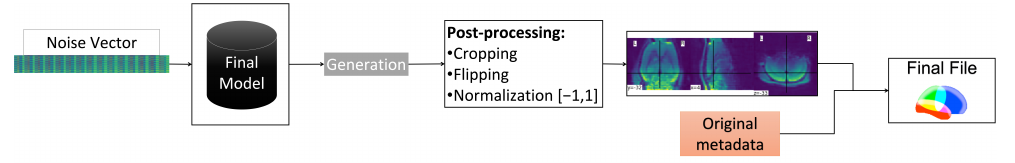
Figure 4. Overall generation